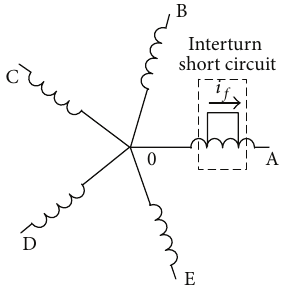
Figure 1: The schematic of five-phase PMSM with interturn short